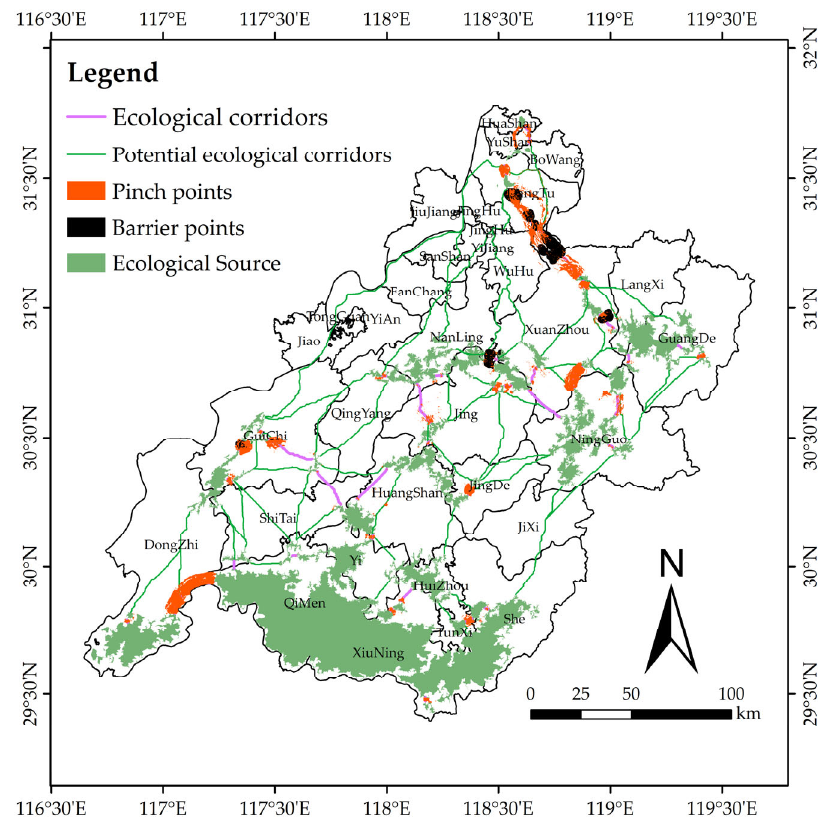
Figure 9. Construction of the ecological security pattern in southern Anhui.